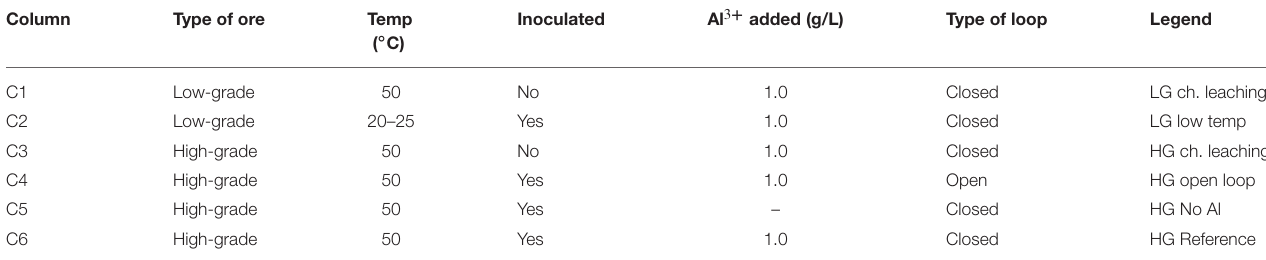
TABLE 3 | Experimental conditions utilized in the bioleaching study.